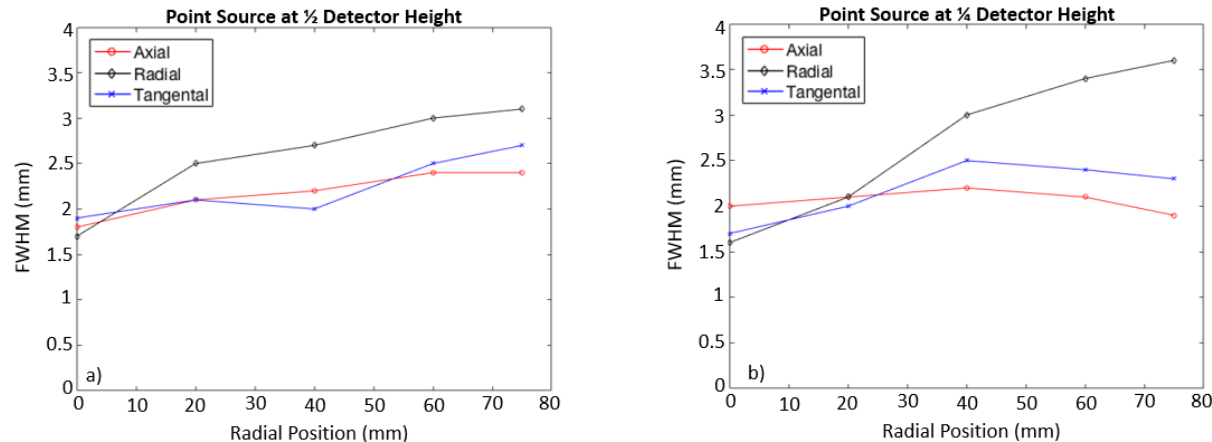
Figure 5. Plots showing the spatial resolution as the point source is moved from the center of VoV to the edge of the VoV. The top graph is for source locations in the ring’s central plane, and the bottom graph is for source locations in a parallel plane, 1.25 cm from the central plane.